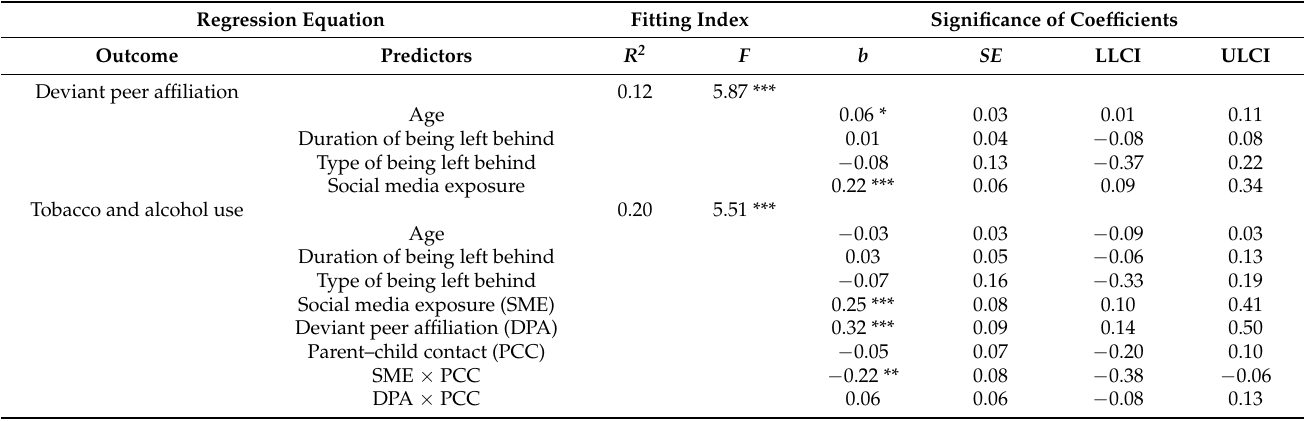
Table 3. Testing the moderated mediation effects among left-behind